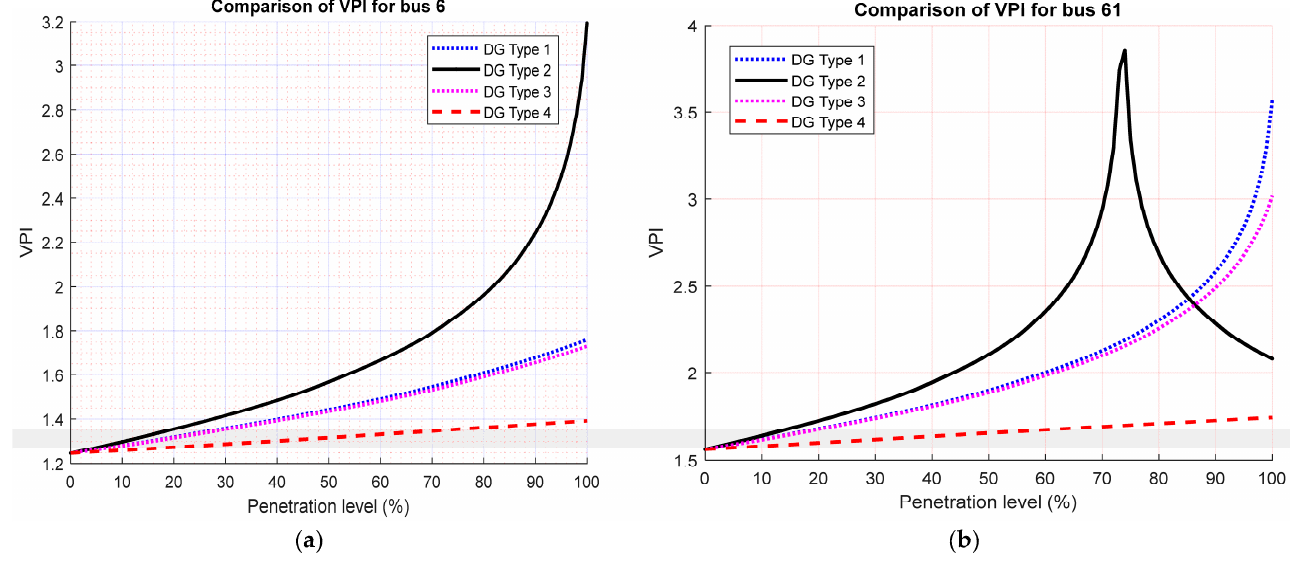
Figure 27. Comparison of VPI by various DG types interconnected to ( a ) bus 6 of IEEE 33-bus and ( b ) bus 61 of the IEEE 69-bus network. Table 6. Optimal allocations deduced for the DG Types.